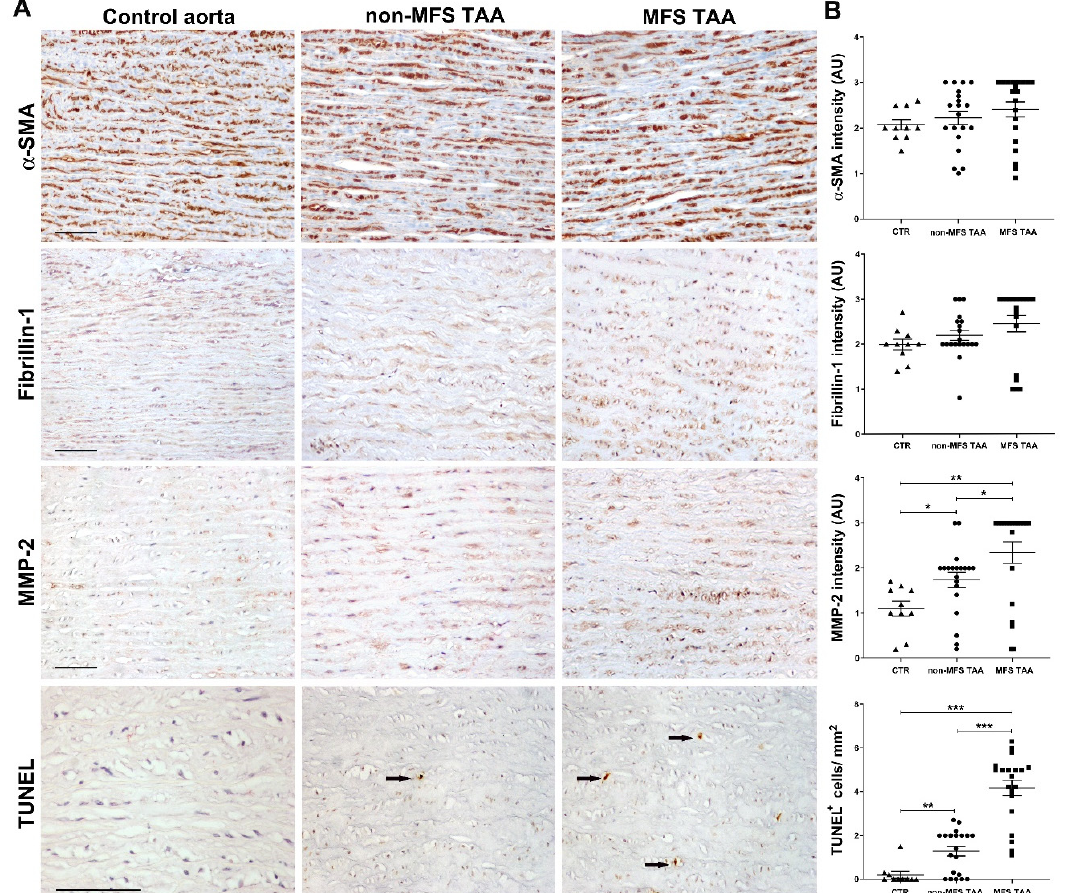
Figure 2. Higher MMP-2 expression and apoptosis characterize MFS thoracic aortic aneurysm. ( A ) Representative images of α -SMA, fibrillin-1, MMP-2 immunostainings and TUNEL assay in the tunica media of MFS and non-MFS thoracic aorta aneurysm (TAA) and control aorta. For TUNEL assay, only strongly positive condensed nuclei were counted (arrows). Scale bars equal to 100 µ m. ( B ) Semiquantitative evaluations of immunoreactivity show increased MMP-2 expression and TUNEL + cells / mm 2 in MFS TAA compared with non-MFS and control aorta. MFS TAA ( n = 20), non-MFS TAA ( n = 20) and control aorta ( n = 10). Average are reported as means ± SEM; * p < 0.05; ** p < 0.01; *** p < 0.001; estimated by t -test. Abbreviations: AU, arbitrary units.